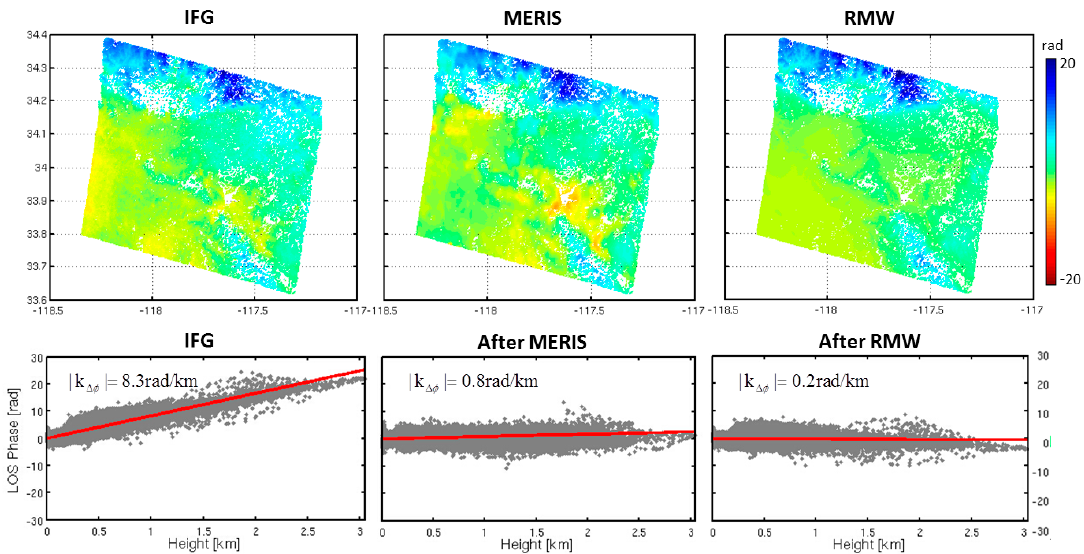
Figure 11. A comparison of the performance of the MERIS correction and the RMW method correction. A stratified dominant interferogram was generated using two SAR acquisitions on 16 August 2008 and 25 October 2008 by the Envisat satellite over California. The average B is 272 m. The original interferogram has been corrected for the residual orbital errors. The tropospheric delay has a strong linear relationship with elevation. The prediction of tropospheric delay using MERIS and the RMW method show a good agreement, with a difference in the standard deviation of 0.1 rad along the LOS. The standard deviation of the residuals after correction using MERIS data was about 1.6 rad and 1.7 rad after correction with the RMW method. The standard deviation reduction after correction with the RMW method was about 55%.